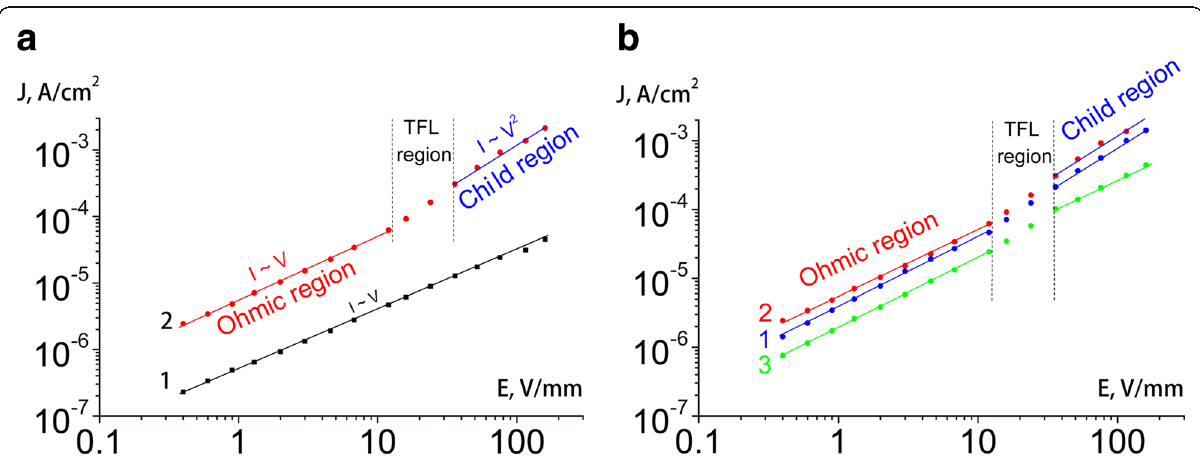
Fig. 7 Dependence of the current density on the voltage of a the organic-inorganic prepared at the ratio of starting reagents (PbI 2 and CH 3 NH 3 І ) 1:2 at different illumination levels, 0 (1) and 30 klx (2), and b the organic-inorganic film prepared at the ratio of starting reagents 1:1 (1), 1:2 (2), and 1:3 (3) at an illumination of 30 klx